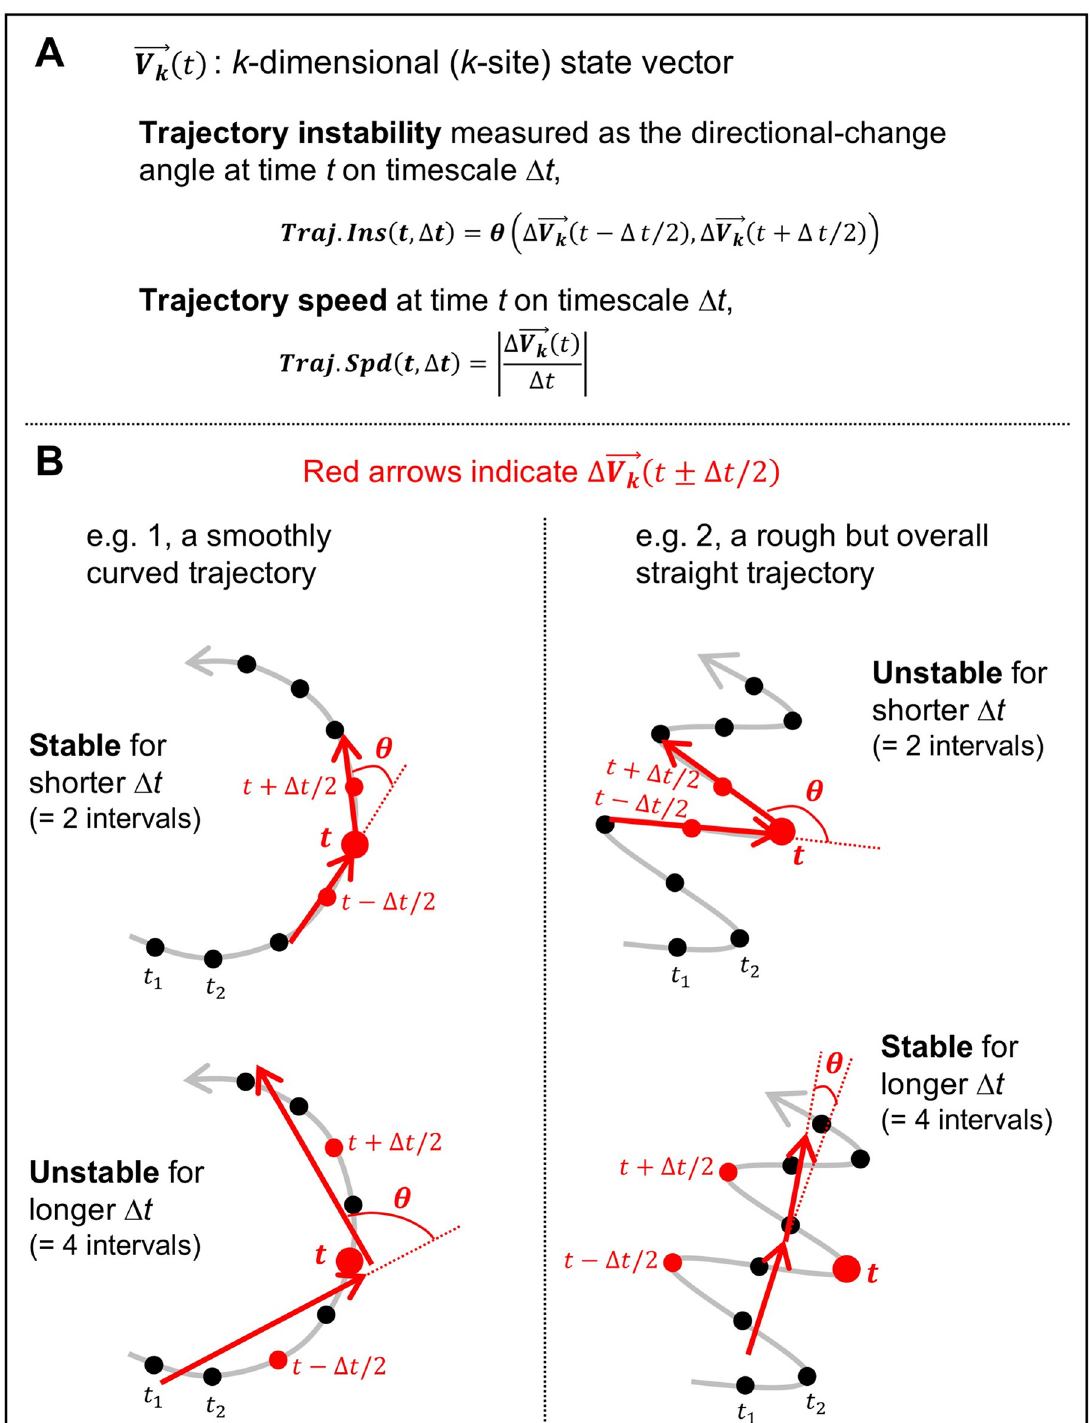
! ��� ! ð t Þ , k ! ��� ! ð t (cid:0) D t = 2 Þ and D V ! ��� ! ð t þ D t = 2 Þ , each k k